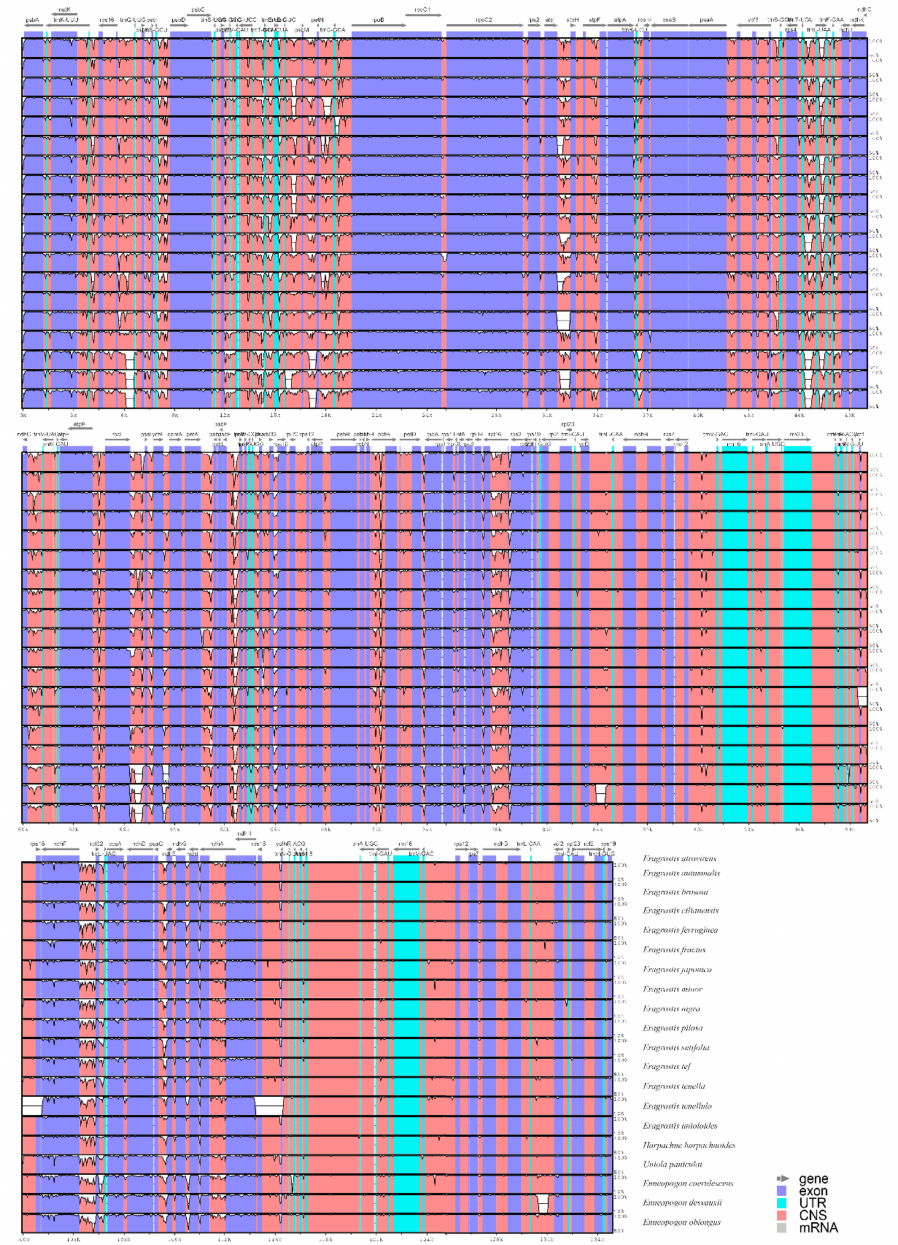
Figure 6. Comparison of 20 Eragrostideae chloroplast genomes using mVISTA alignment program with E. atrovirens as a reference. Genome regions are color-coded: blue blocks, exons of protein-coding genes (exon); sky-blue blocks, tRNA and rRNA genes; red blocks, conserved noncoding sequences (CNS). The vertical scale represents a 50–100% of